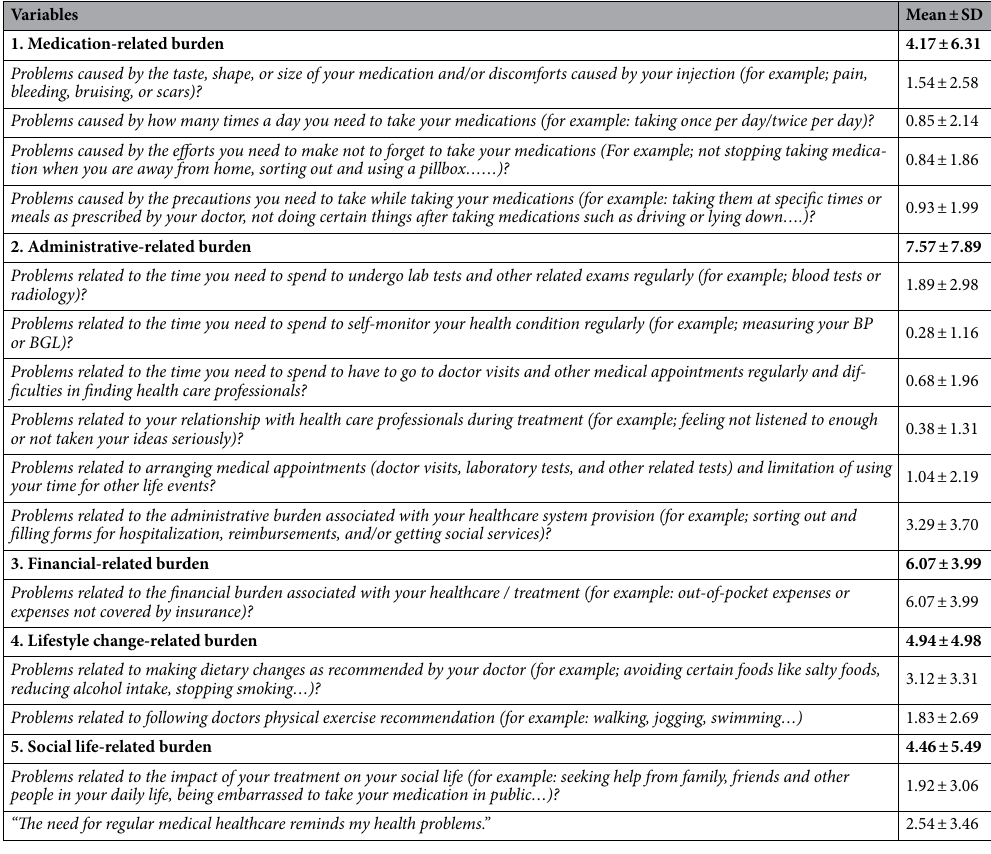
Table 4. Analysis of five dimensions of TBQ among HF patients attending cardiac clinic of